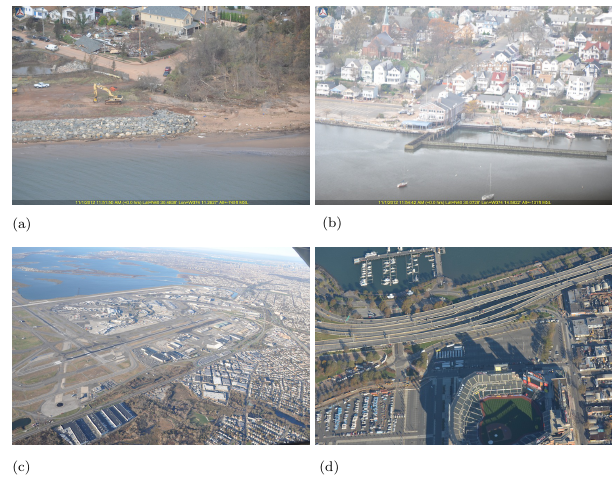
Fig. 9. (a) Flooding documented by the Civil Air Patrol and FEMA. (b) Flooding documented by the Civil Air Patrol and FEMA. (c) No Figure 9: Agreement between Civil Air Patrol photos and FEMA evaluation for flooded (a and b) not flooded (c and d). flood damage documented by the Civil Air Patrol and FEMA. (d) No flood damage documented by the Civil Air Patrol and FEMA. Agreement between Civil Air Patrol photos and FEMA evaluation for flooded ( a and b ) not flooded ( c and d ).